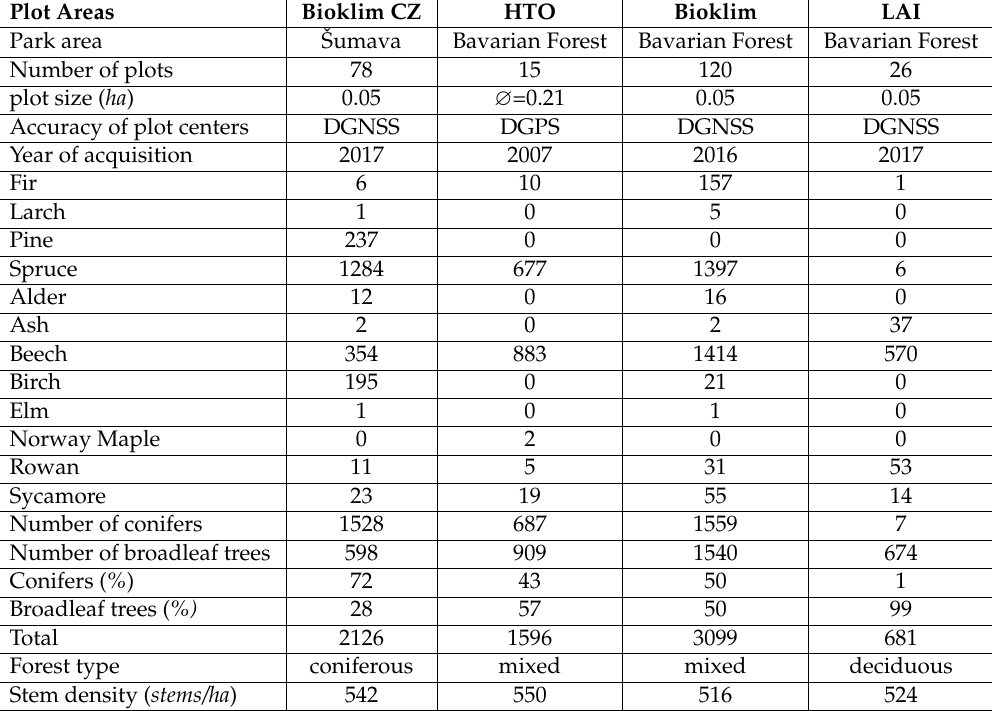
Table 3. Properties of reference plots from field measurements.